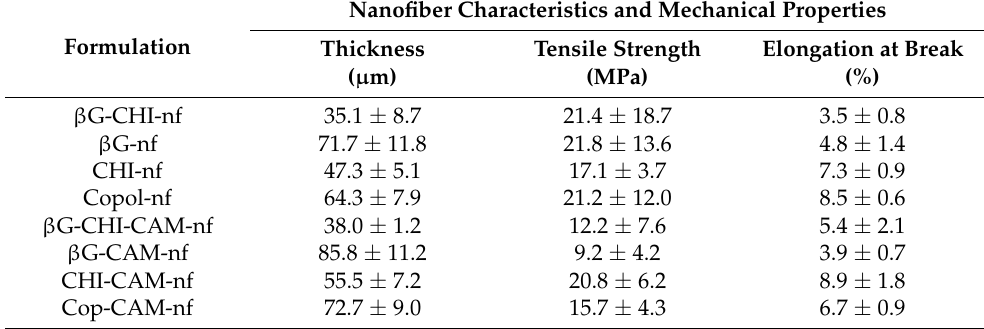
Table 3. Mechanical characteristics of nanofibers. Results are presented as mean ± SD ( n = 3).